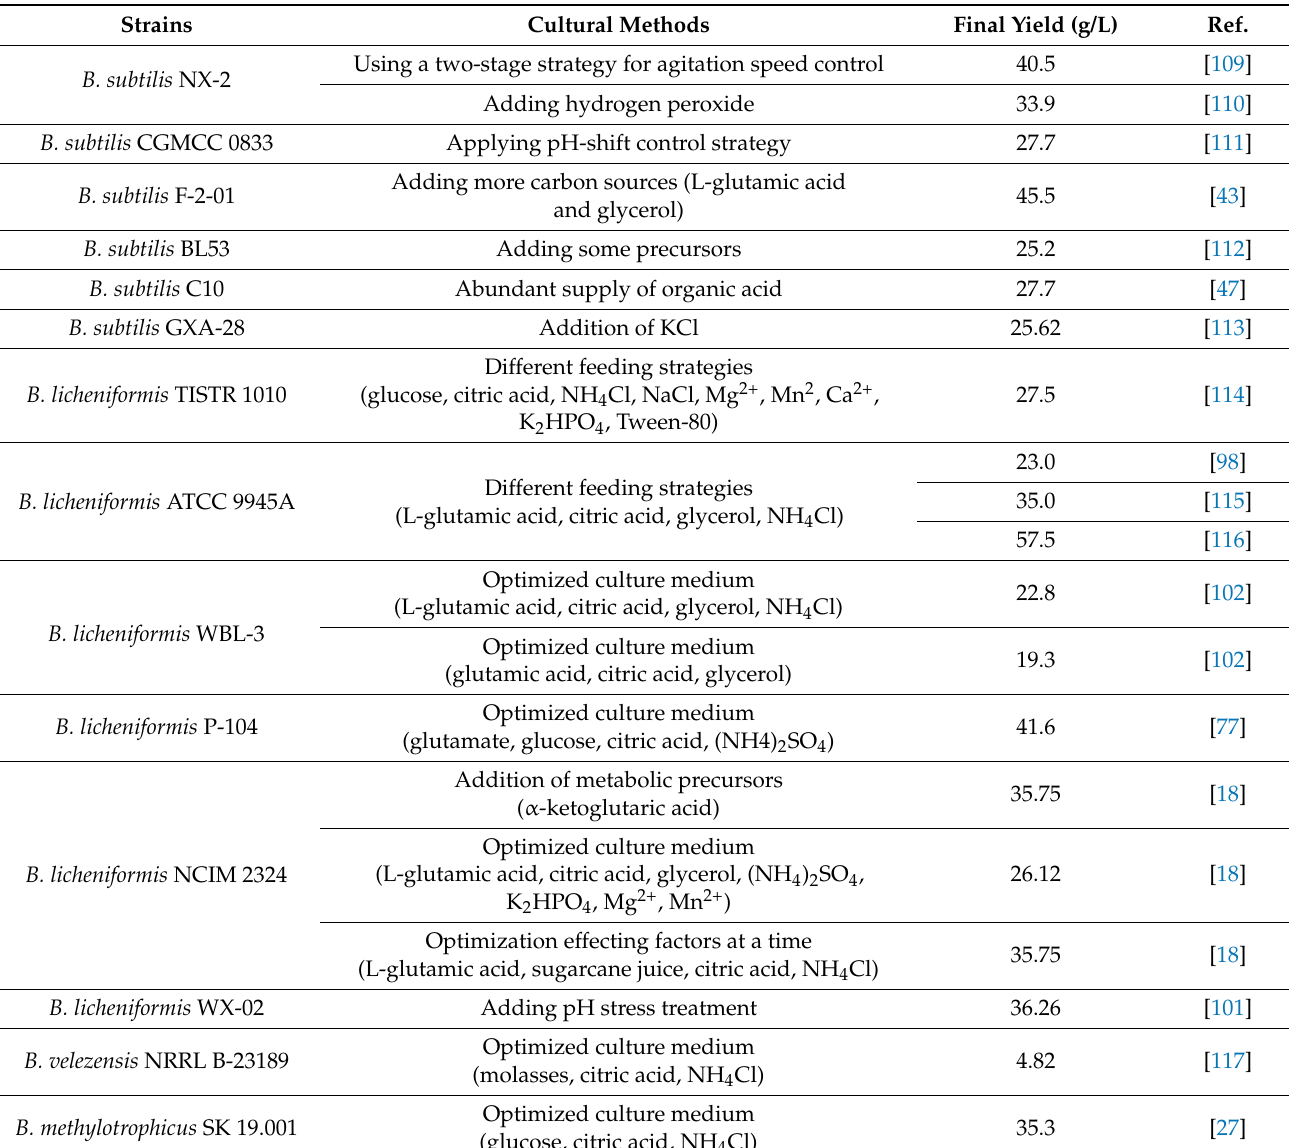
Table 4. The culture methods of γ